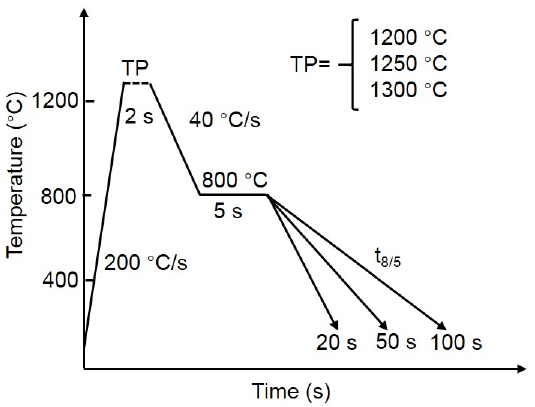
Figure 3. Thermal simulation test